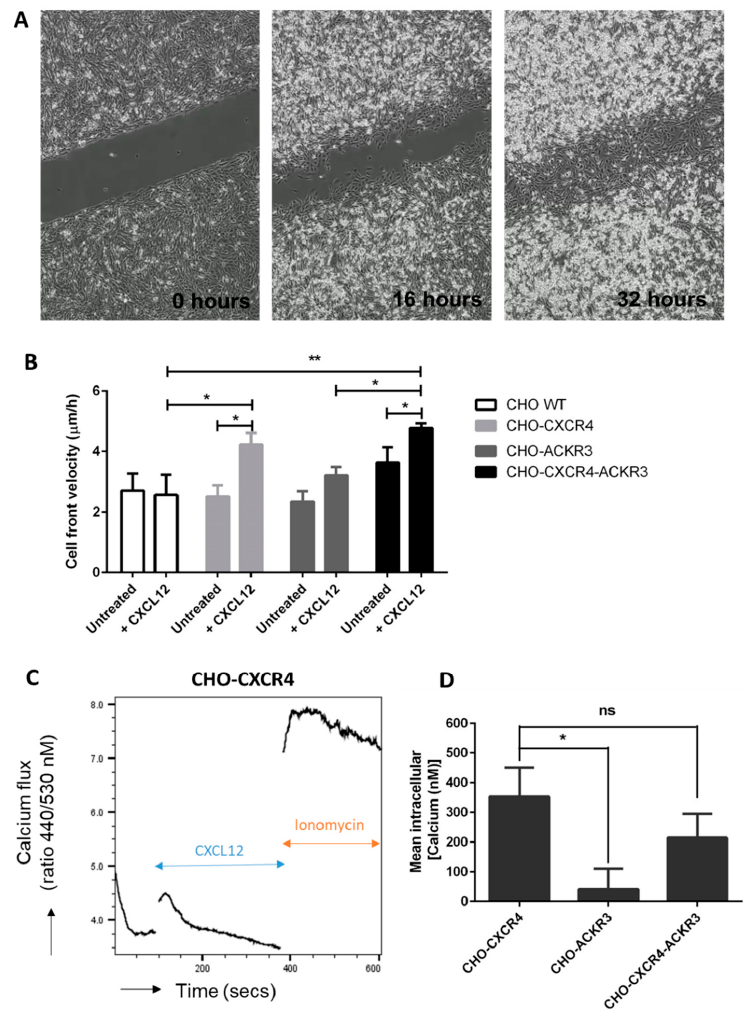
Figure 7. CXCR4 but not ACKR3, has an effect in wound healing after CXCL12 stimulation. CHO-WT, CHO-CXCR4, CHO-ACKR3 and CHO-CXCR4-ACKR3 cells were seeded into Ibidi inserts to create